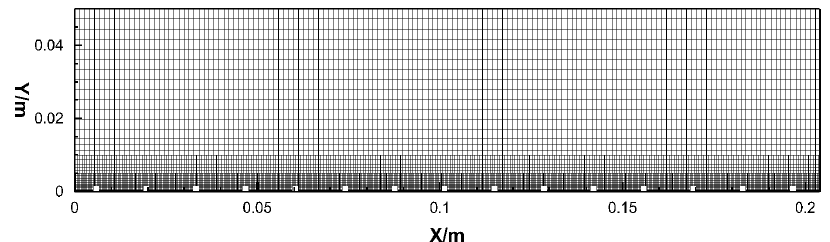
Figure 1. Domain and mesh of the validation simulation.